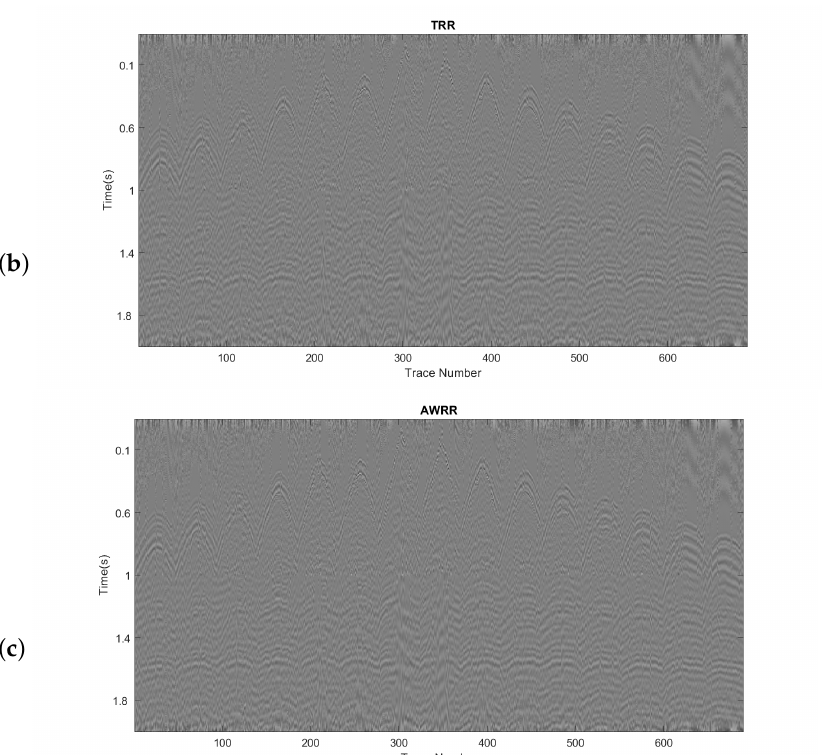
Figure 16. ( a ) Input real data, ( b ) interpolation result of applying TRR approach, ( c ) interpolation result of applying the AWRR method.